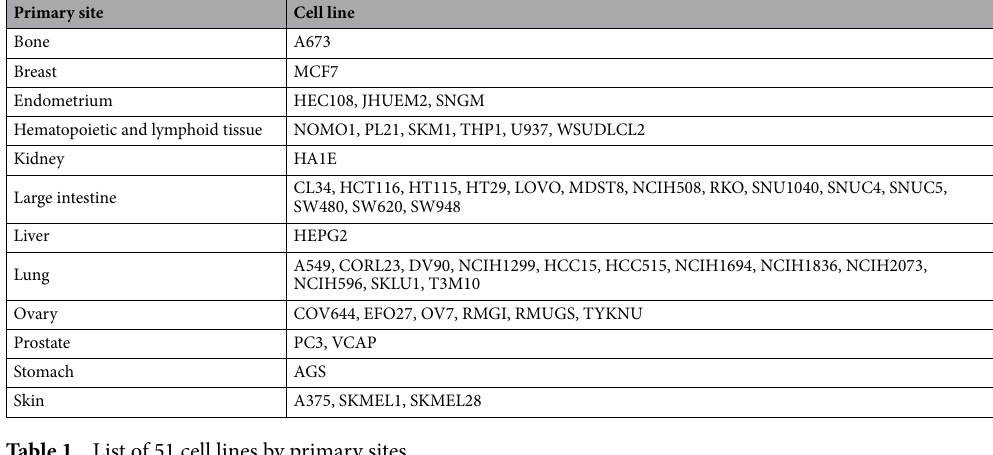
Table 1. List of 51 cell lines by primary sites.